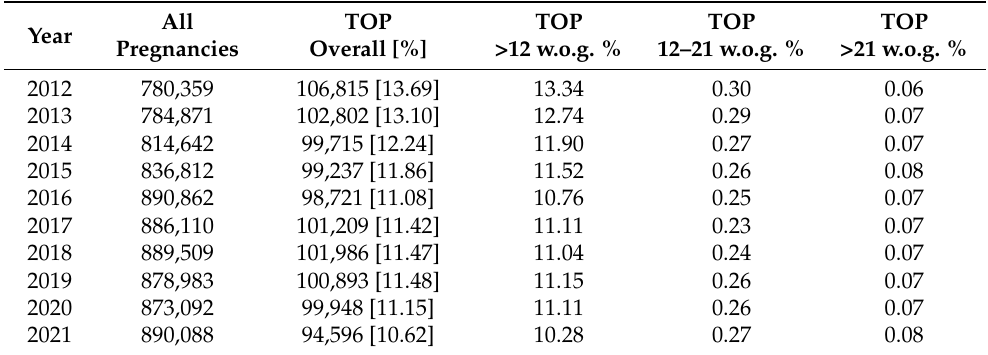
Table 2. All pregnancies in Germany, compared to the number/percentages of induced abortions (TOP), according to [40,41]. All TOP TOP TOP TOP Year Pregnancies Overall [%] >12 w.o.g. % 12–21 w.o.g. % >21 w.o.g. %